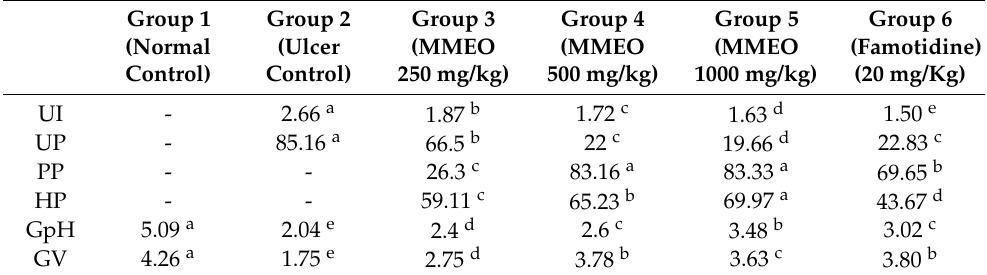
Table 2. Effect of oral pre-treatment with microencapsulated myrtle essential oil (MMEO) on gastric ulcer parameters in rats ( n = 6/group).